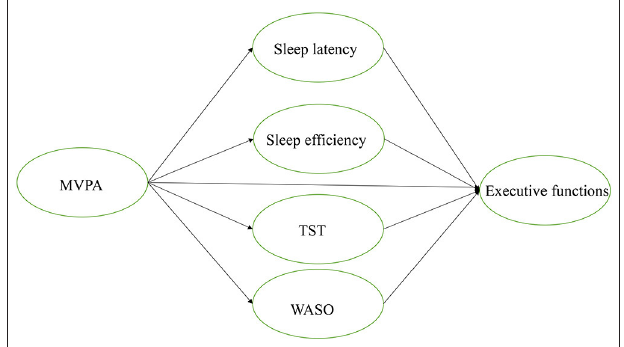
FIGURE 1 | Hypothesized model. MVPA, moderate to vigorous physical activity, TST, total sleep time; WASO, waking after sleep onset.